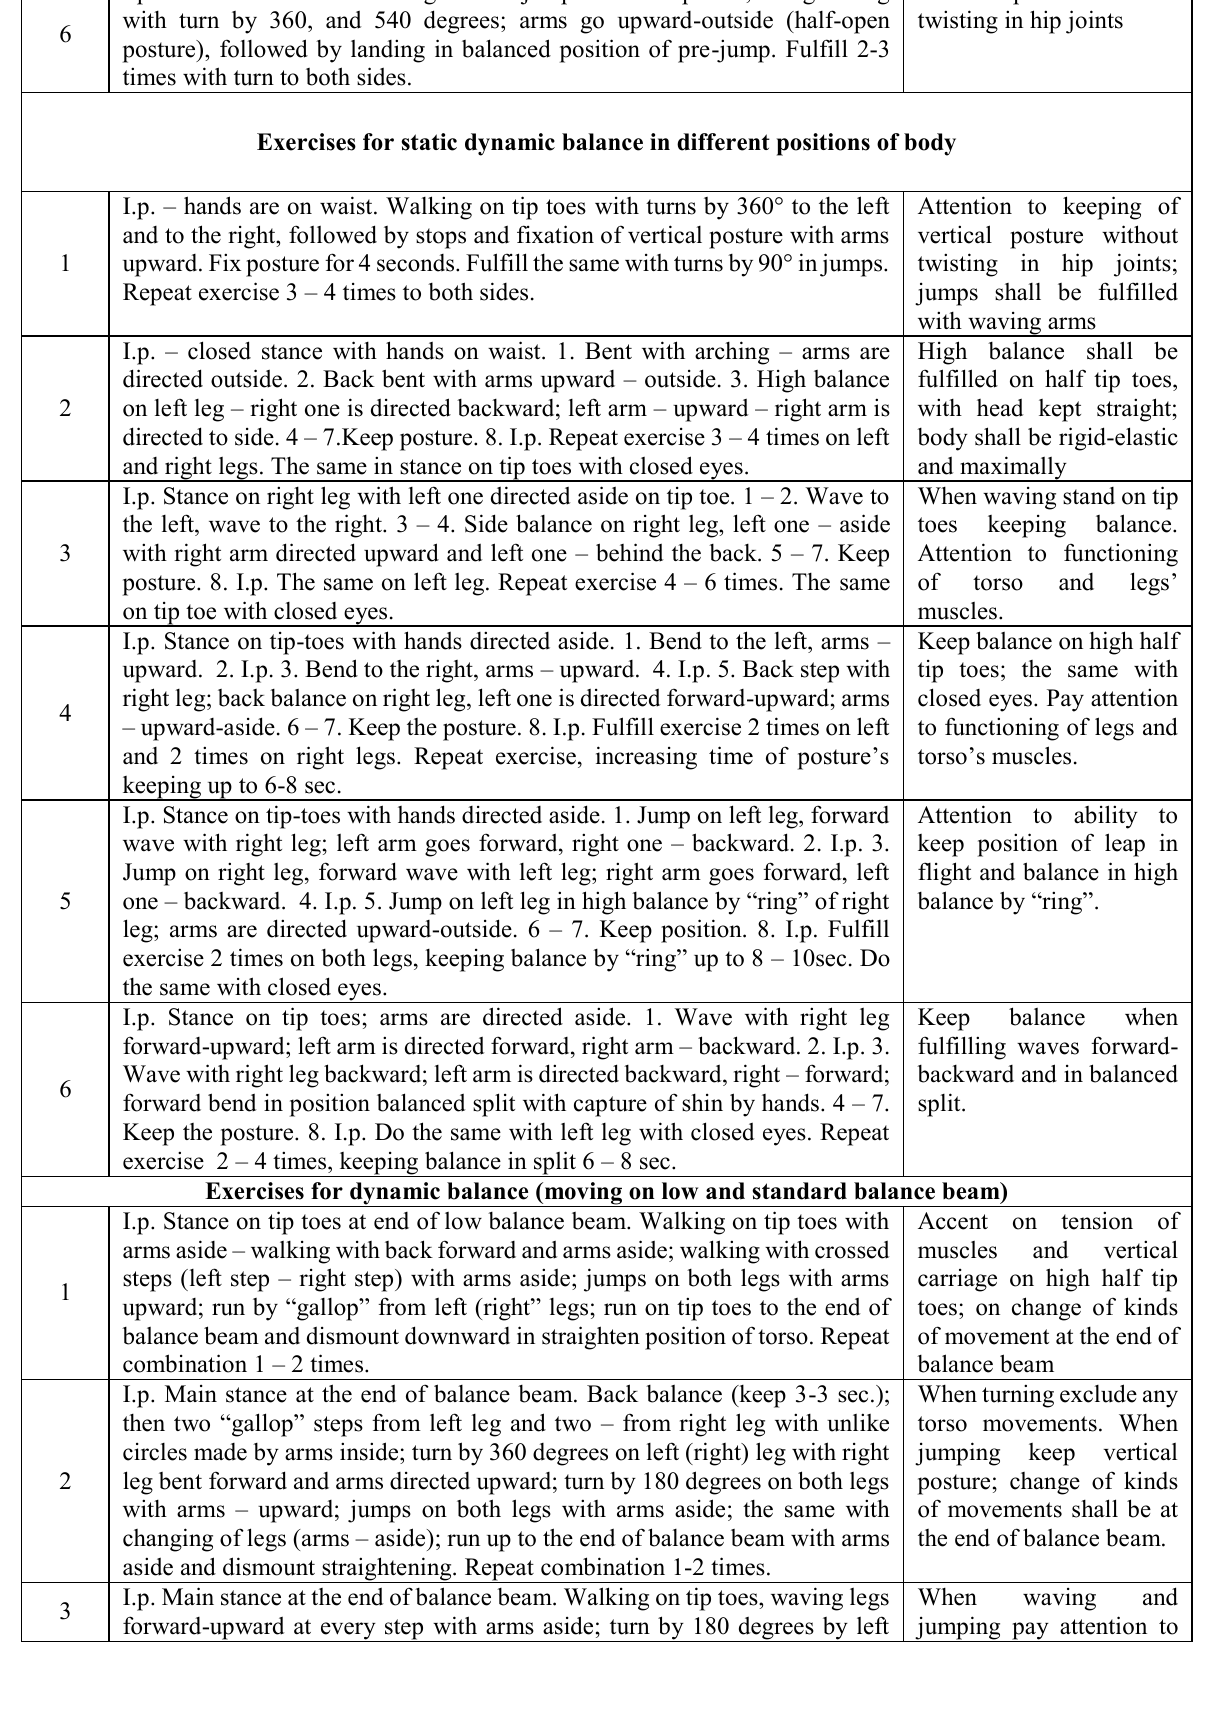
Vertical posture without twisting in hip joints